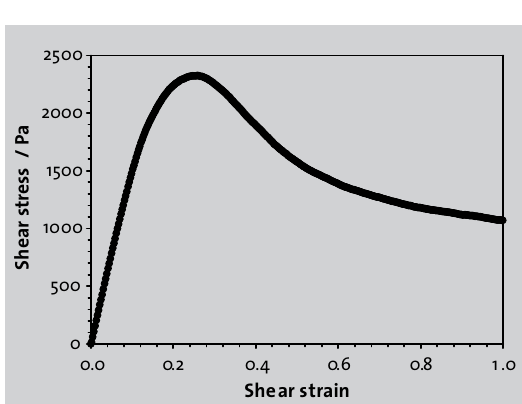
Figure 4 (above): Confocal microscopic pic- tures of a) maltodextrin rich phase and b) agarose rich phase, obtained from the phase separation of 12.5 % SA2 / 5 % Ag mixture and cooled down at 10ºC. Figure 5 (left below): Fracture of a two layer mal- todextrin/agarose gel by tensile test. Figure 6 (right below): Large deformation behav- iour of maltodextrin/aga- rose gel composite with maltodextrin rich phase being the continuous phase (75 %). The rich phases were obtained from the phase separation of 12.5 % SA2 / 5 % Ag (Vane rheometer, shear rate: 0.05 s -1 , T : cup